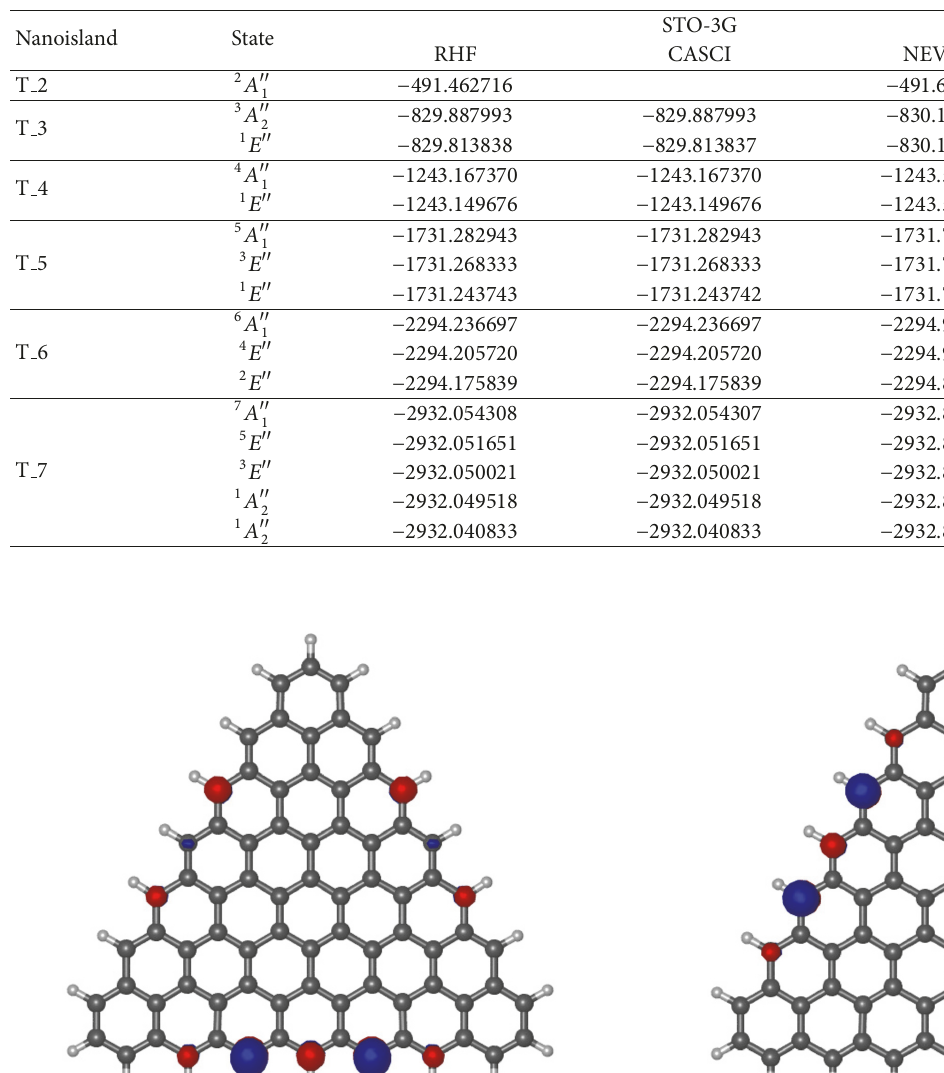
Table 10: Energies for the different triangle nanoislands in hartree.